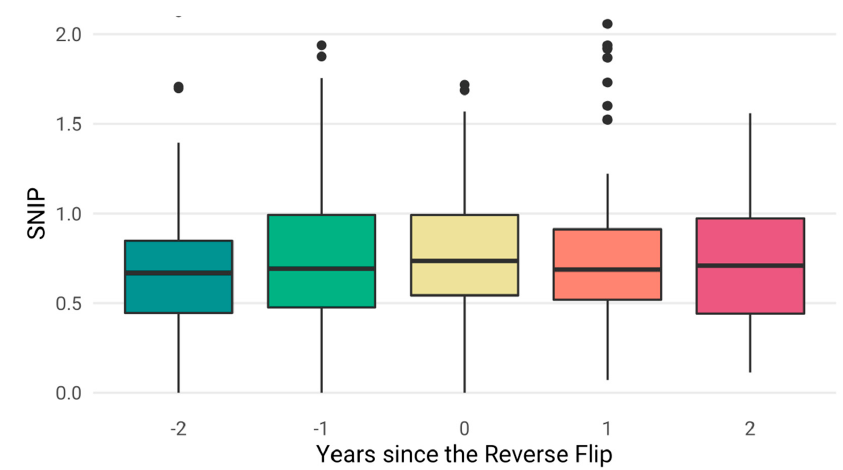
Figure 12. Development of Source Normalized Impact per Paper (SNIP) value between two years before and after the reverse flip ( Y -axis limited to SNIP value 2.5).